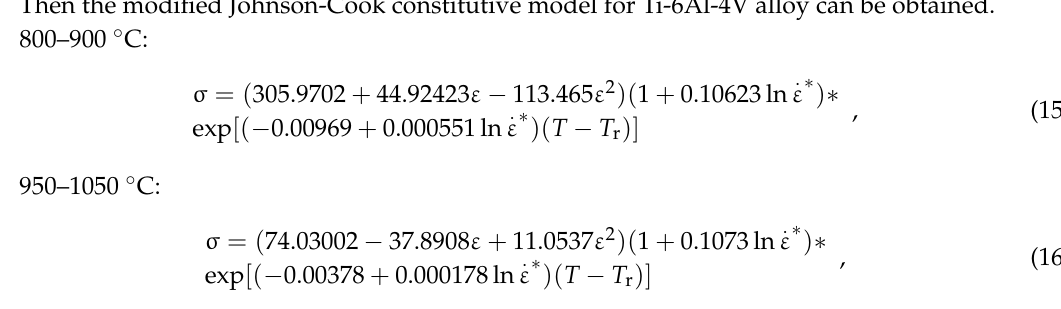
Figure 6. The relationships between ln{ σ /( A 1 + B 1 ε + B 2 ε 2 )(1 + C 1 ln